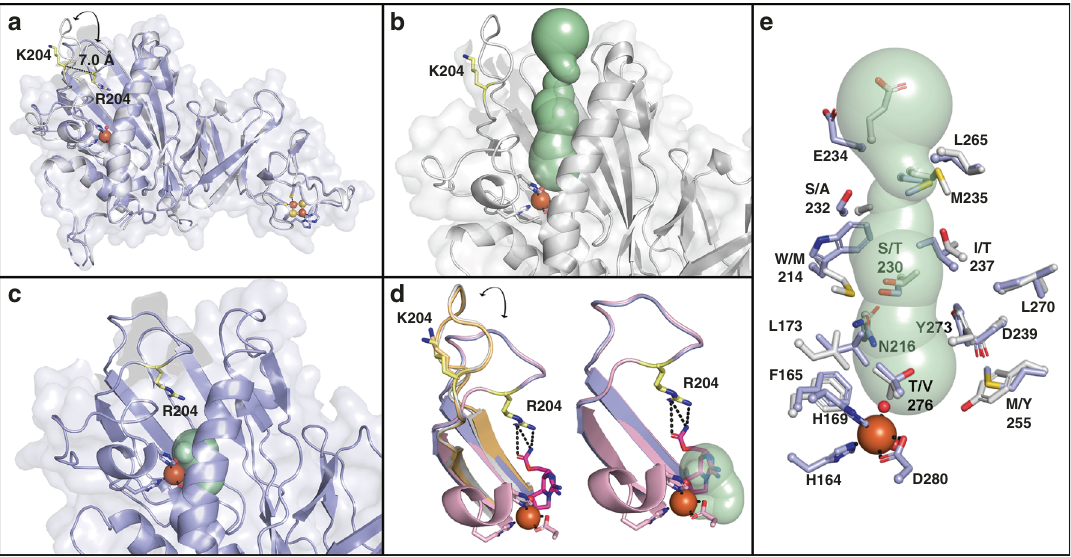
Fig. 5 SxtT and GxtA exhibit different conformations of a loop that appears to gate access to the active site. a An overlay of the SxtT and GxtA monomers reveals a 7.0 Å difference in the location of the residue at the 204 position. This difference is due to changes in the position of a loop that spans the range 195 – 215. b The open conformation of the loop in GxtA allows visualization of a tunnel that leads directly from the protein surface to the active site. c The closed orientation of the loop in SxtT restricts calculation of an equivalent tunnel, but instead allows visualization of the active site cavity. d An overlay of all four structures determined in this work reveals that Arg204 in the co-crystal structure assumes a similar position to that seen in the ligand free structure of SxtT. In this orientation, Arg204 interacts with ddSTX. e An overlay of SxtT and GxtA shows differences in the residues that line the putative tunnel to the active site. In all panels, structures are shown for SxtT, GxtA, ddSTX-SxtT, and ddSTX-GxtA in purple, gray, pink, and orange respectively. Tunnels are colored mint, ddSTX is dark pink, and the Arg/Lys204 residue is